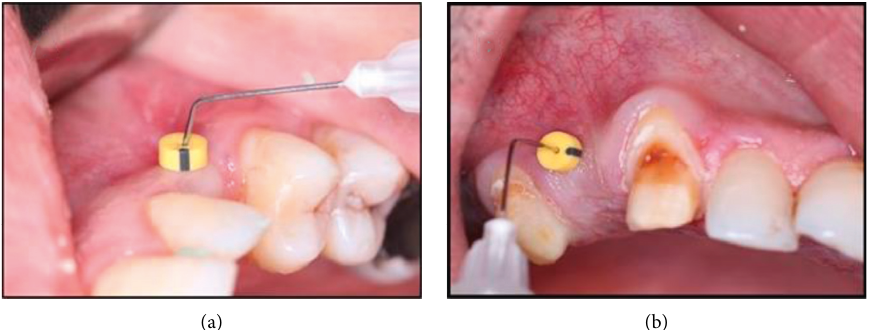
Figure 5: Clinical photos showing measuring keratinized tissue thickness. (a) Needle piercing the keratinized mucosa to measure ker- atinized tissue thickness at 2mms and (b) needle piercing the keratinized mucosa to measure keratinized tissue thickness at 4mms.